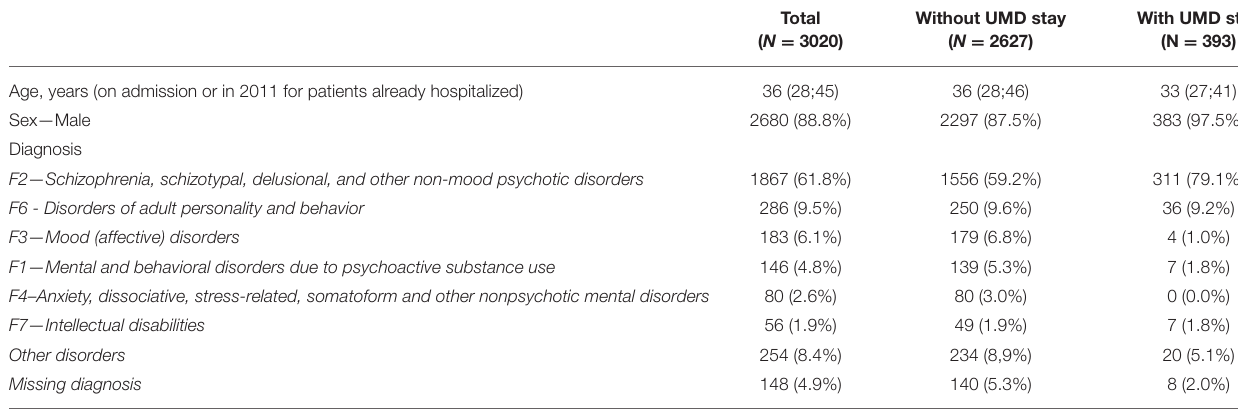
TABLE 1 | Demographic characteristics and diagnoses of individuals found not criminally responsible on account of mental disorder and referred to psychiatric hospitalization in France